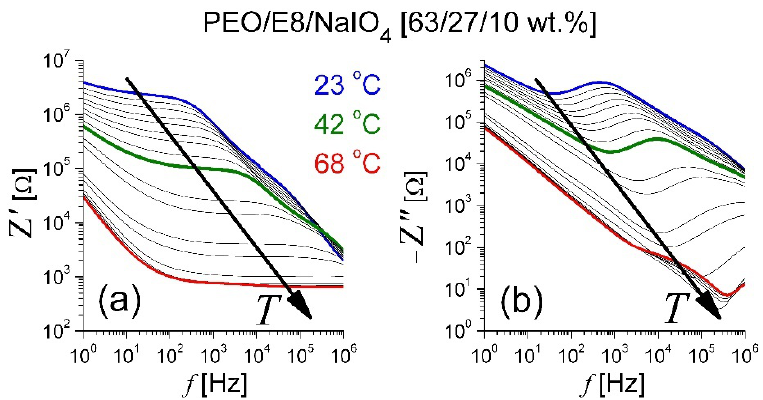
Figure 3. Frequency spectra of complex electrical impedance of PEO/E8/NaIO 4 composite film: ( a ) real part ( Z′ ) and ( b ) imaginary part ( Z″ ). Spectra were recorded under identical experimental conditions, by varying the temperature of the film in the range of 22 °C to 68 °C. The arrows show the effect of increasing temperature.